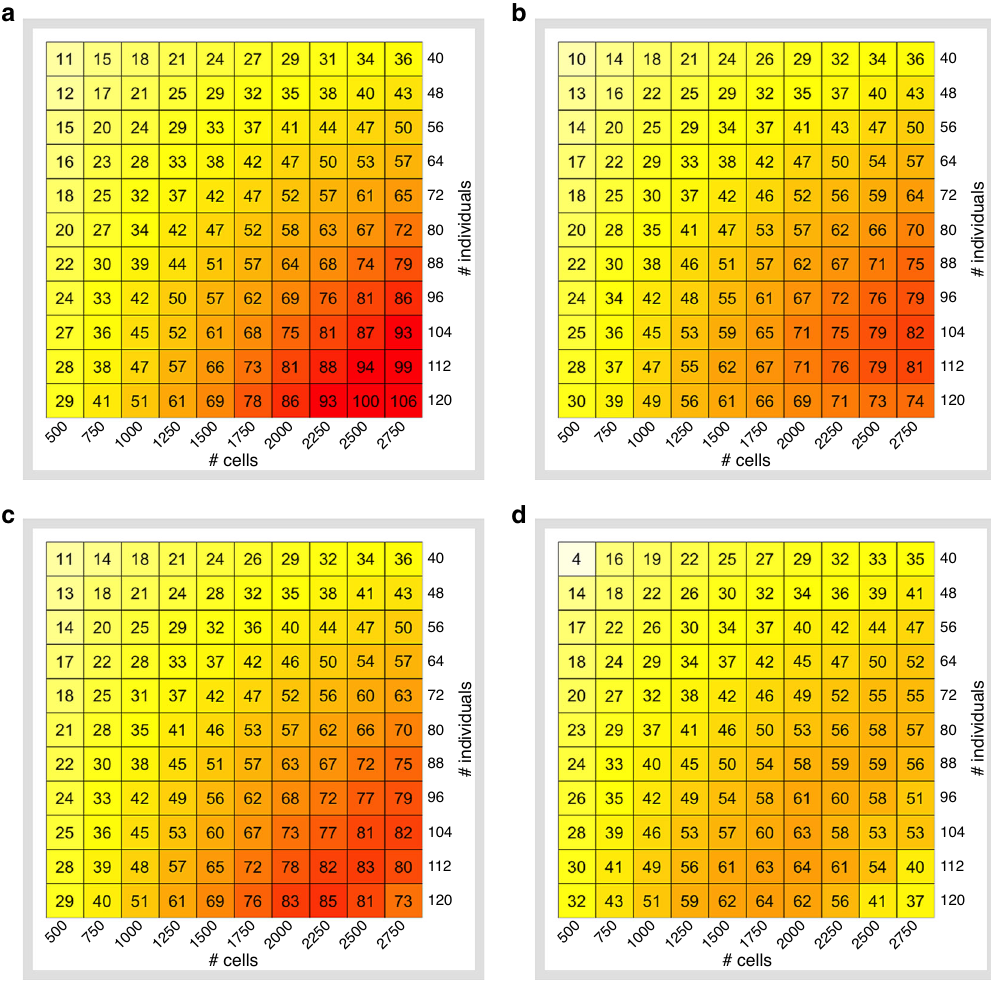
Fig. 2 Effective sample size across a grid of experimental designs. Sample size N ranges from 40 to 120 individuals in steps of 8 and the number of cells per individuals M ranges from 500 to 2750 cells per individual in steps of 250 (CD4 T cells). a Library preparation is assumed to be 0$ per reaction, level of multiplexing is fi xed and equal to 8. b Library preparation is set to $2000 per reaction, level of multiplexing is fi xed and equal to 8. c Library preparation is set to $2000 per reaction, greedy multiplexing. d Library preparation is set to $2000 per reaction, greedy multiplexing, demultiplexing inaccuracy, and cell-type misclassi fi cation is taken into